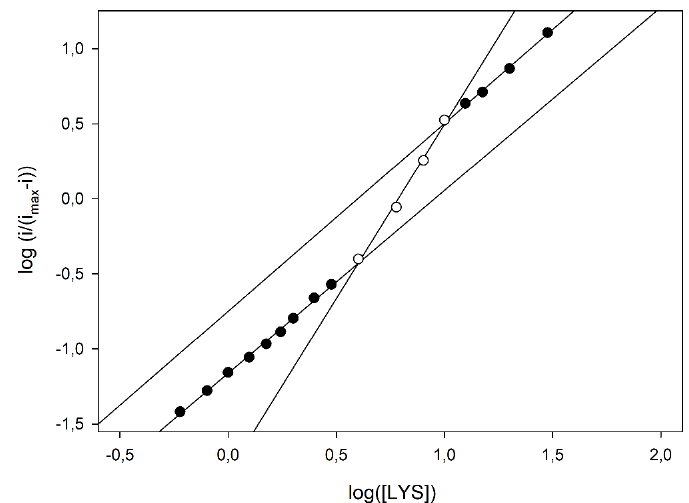
Figure 5. Hill plot of normalised current responses due to injections of L-lysine standard solutions at the amperometric enzyme electrode as a function of L-lysine concentration at pH 9. Straight lines refer to linear fitting of data points (see manuscript for further explanation about). Flow rate: 1.0 mL min − 1 ; other experimental conditions are described in the Materials and Methods section.